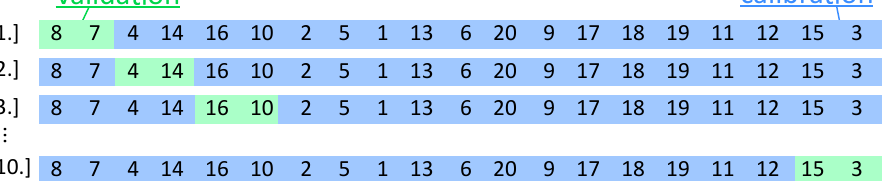
Figure 3. The cross-validation: one random permutation of input data is divided into 10 parts, 9 of them are used for calibration, the remaining one is used for validation. On one specific data permutation, we obtain 10 different calibration results. In this figure, we demonstrate the process on the data of length T = 20; however, our real dataset is of length T = 2191.